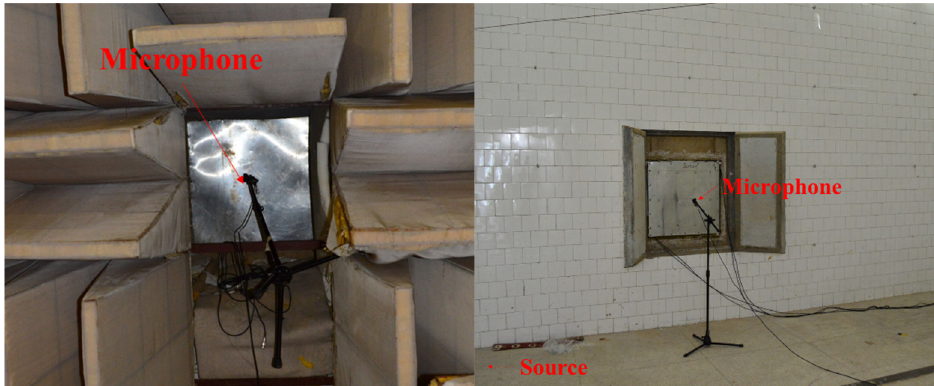
Figure 32. Schematics of the sound transmission loss test.